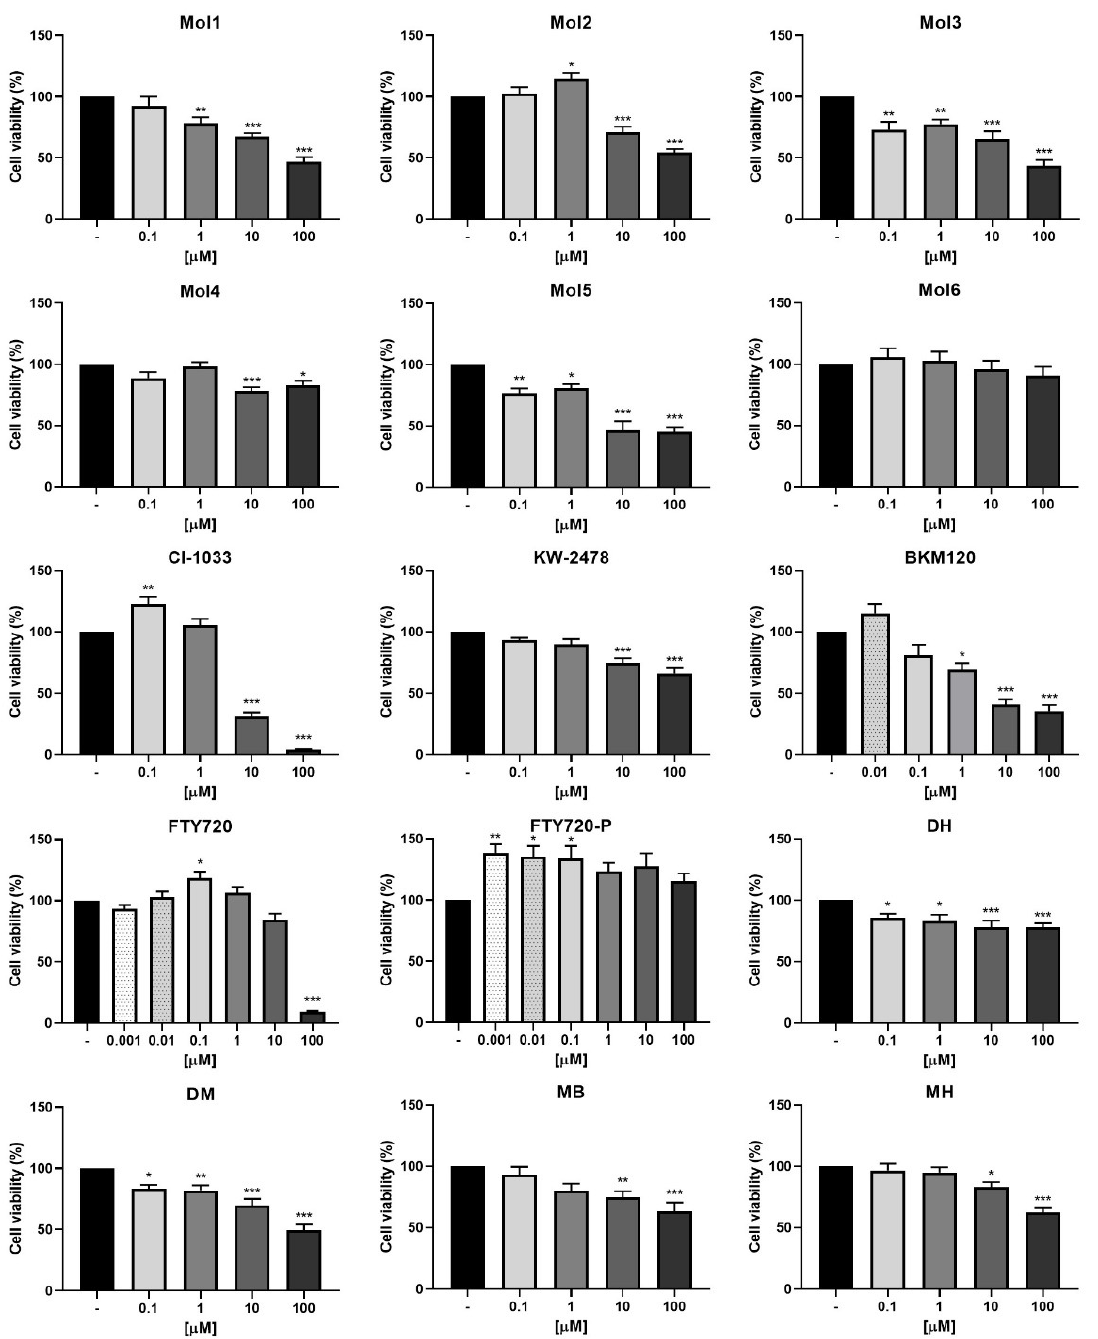
Figure 1. b.End5 cells viability upon exposure to drugs. B.End5 cells were treated with the indicated concentrations of each drug, or DMEM (untreated), for 24 h. Cell viability was assessed by the MTT assay, and the values are presented as percentage relative to untreated cells. Mol1, Mol2, Mol4, Mol6, CI-1033, KW-2478, BKM120, FTY720, FTY720-P, MB, and MH caused no toxicity at the lowest concentrations tested. All values are mean ± SEM of three independent experiments performed in triplicate. Statistical significances are shown as * p < 0.5, ** p < 0.01, and *** p < 0.001 vs. untreated.